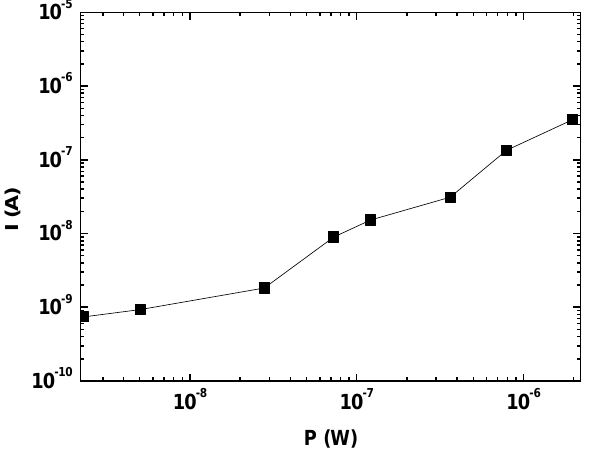
Figure 5. Photogenerated current versus incident optical power of a green LED at zero voltage